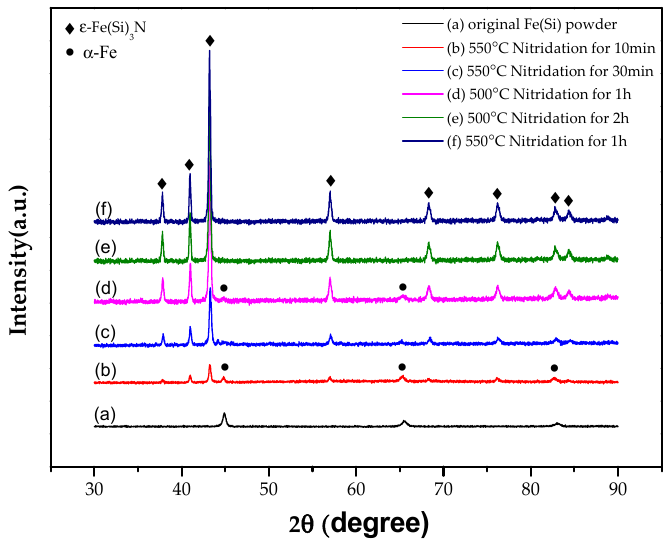
Figure 3. XRD spectra of different powder samples. ( a ) Flaky FeSi alloy powder. ( b – f ) Nitriding samples at different temperatures and times.